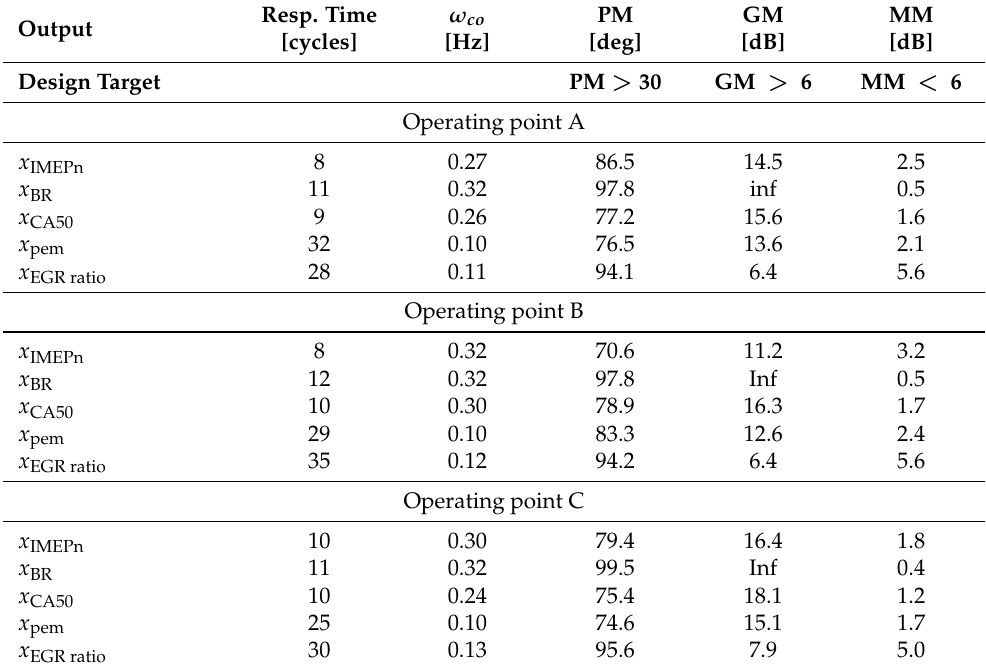
Table 6. Performance indicators and robustness margins of the five SISO feedback controllers for operating points A, B, and C.